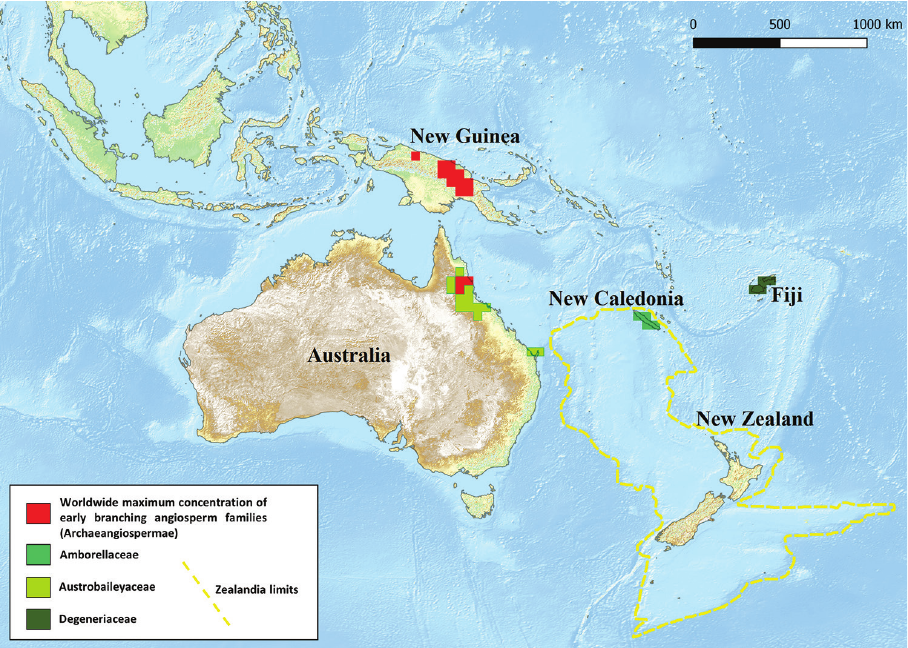
Figure 1. Worldwide maximum concentration of early branching families. Red cells highlight the worldwide highest concentration (15/26, about 60%) of ‘Archaeangiospermae’ sensu Stuessy (2010). Cells in different tones of green highlight three families (Amborellaceae, Austrobaileyaceae, Degeneriaceae) endemic to New Caledonia, NE Australia, and Fiji, respectively. Zealandia continent (yellow dashed line) is drawn according to Mortimer et al. (2017). The distribution of Archaeangiosperm families was obtained from Angiosperm Phylogeny Website (Stevens 2001 onwards), then georeferenced and superimposed through raster analyses in GIS environment, by means of R software (R Core Team